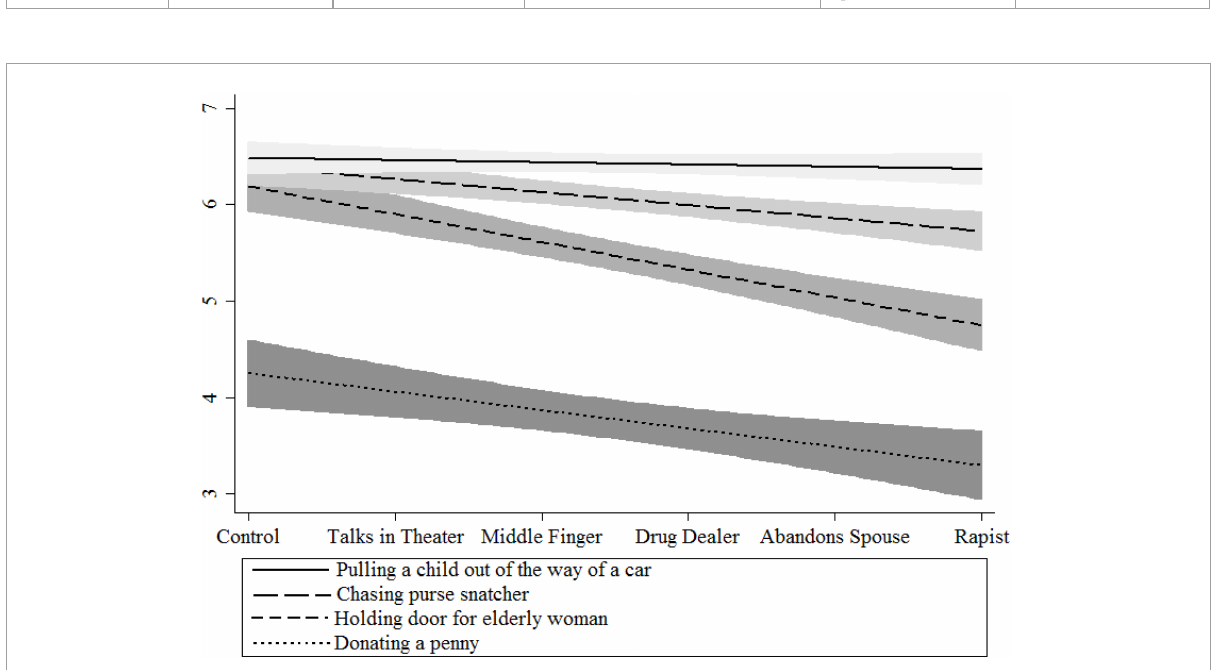
FIGURE6 Dose–response fitted lines of moral